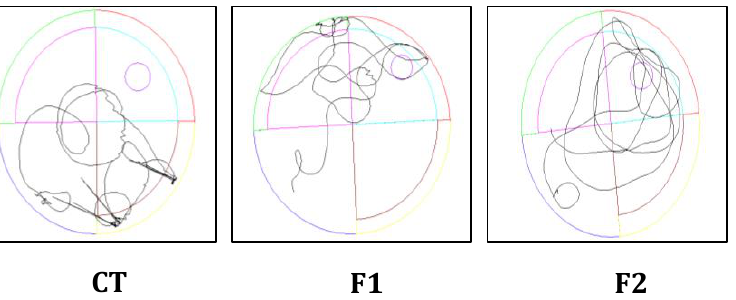
Figure 2. Results of DI of Novel Object Recognition Test (NORT) in females and males at 6 months of age in both females and males for all mice groups. Summary from short-term memory ( A ), and a summary from long-term memory ( B ). Results of Morris Water Maze (MWM) in females and males at 6 months of age for all mice groups. Learning curves of MWM during the spatial acquisition phase ( C ). Latency to the target of MWM on the memory test ( D ). Representative swim paths on the memory test ( E ). Values represented are mean ± SEM; n = 60 (CT n = 20, F1 = 20, F2 n = 20; for each group, females n = 10, males n = 10). Statistics: vs. female CT group: * p < 0.05; ** p < 0.01; **** p < 0.0001 vs. male CT group: $ p < 0.05; $$ p < 0.01; $$$$ p < 0.0001.